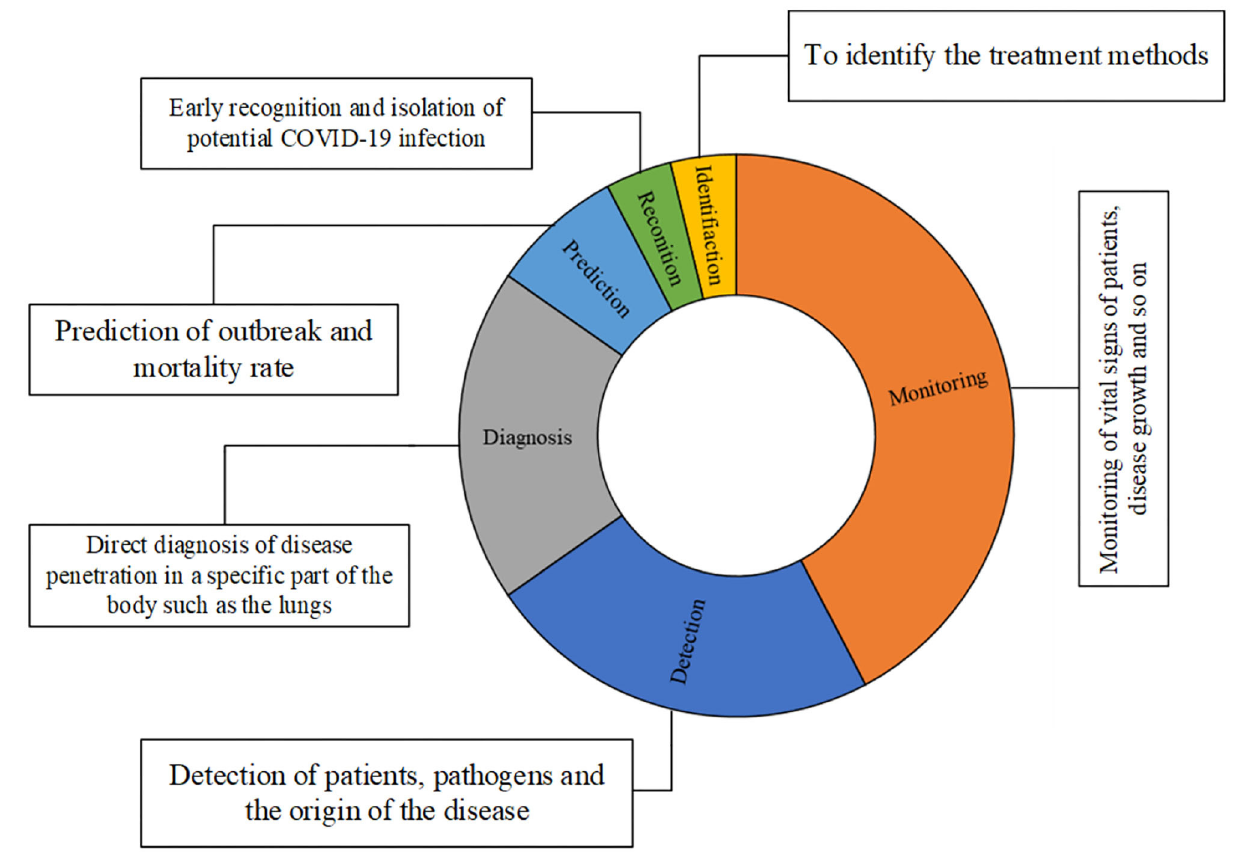
FIGURE 2 | The share of each application type for IoT-based